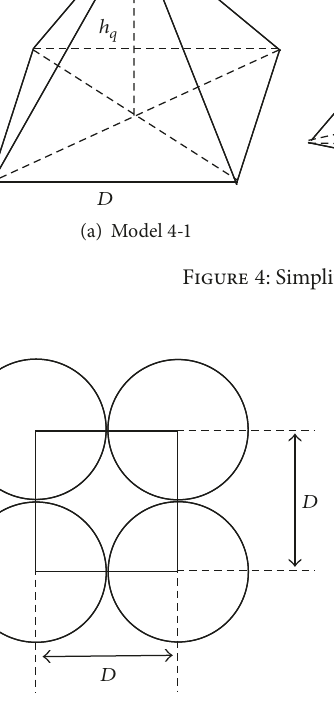
𝑚 is the mass of proppants, g; 𝜌 is the apparent density of proppant, g/cm 3 ; S is the area of facture wall, cm 2 . D is the diameter of proppant,